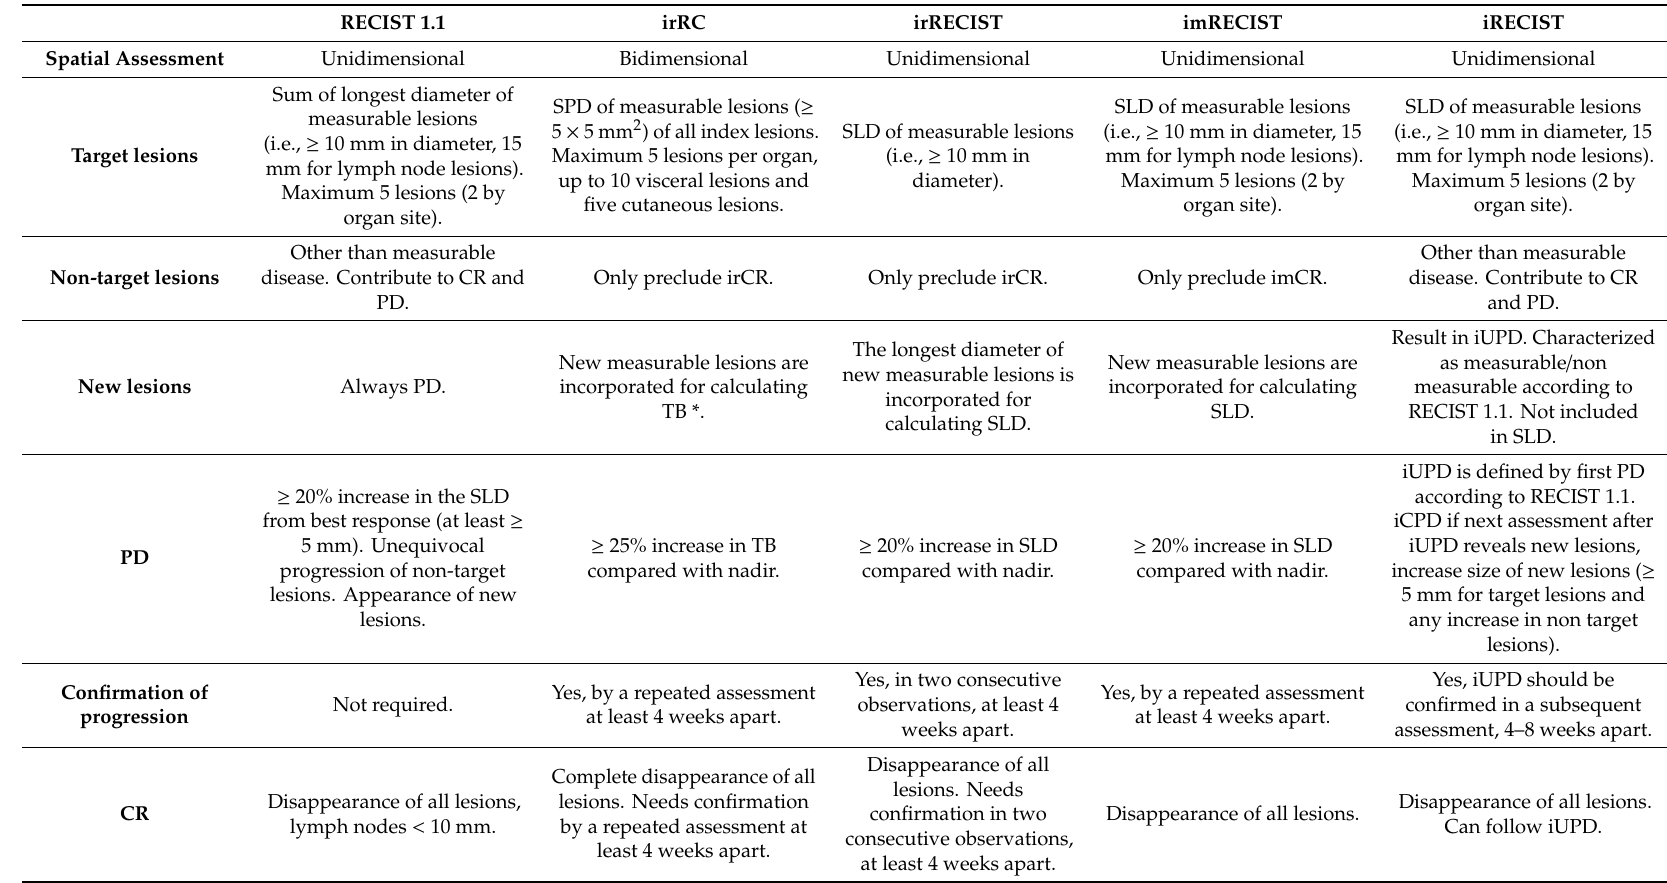
Table 1. Immune-modified